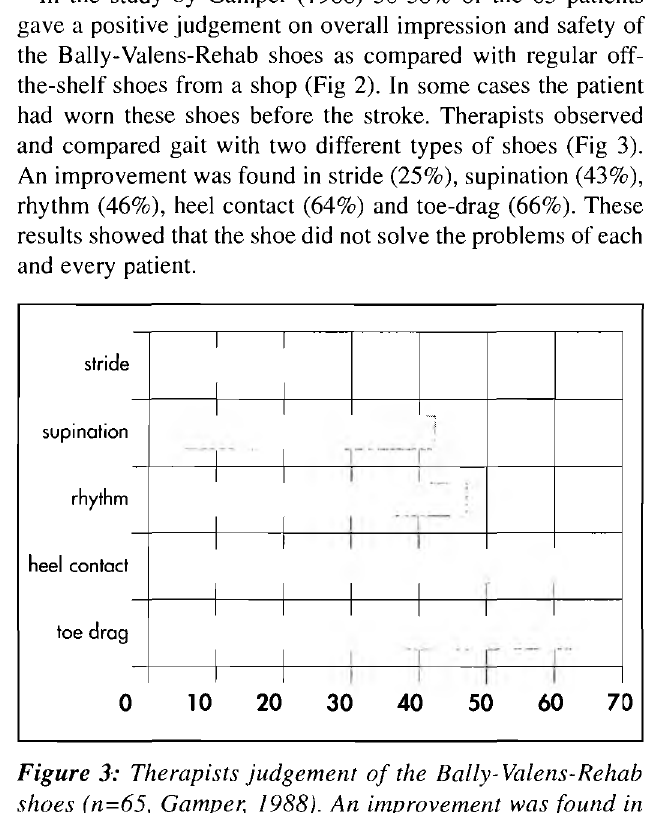
Figure 3: Therapists judgement o f the Bally-Valens-Rehab shoes (n=65, Gamper, 1988). An improvement was found in stride (25%), supination (43%), rhythm (46%), heel contact (64%) and toe drag